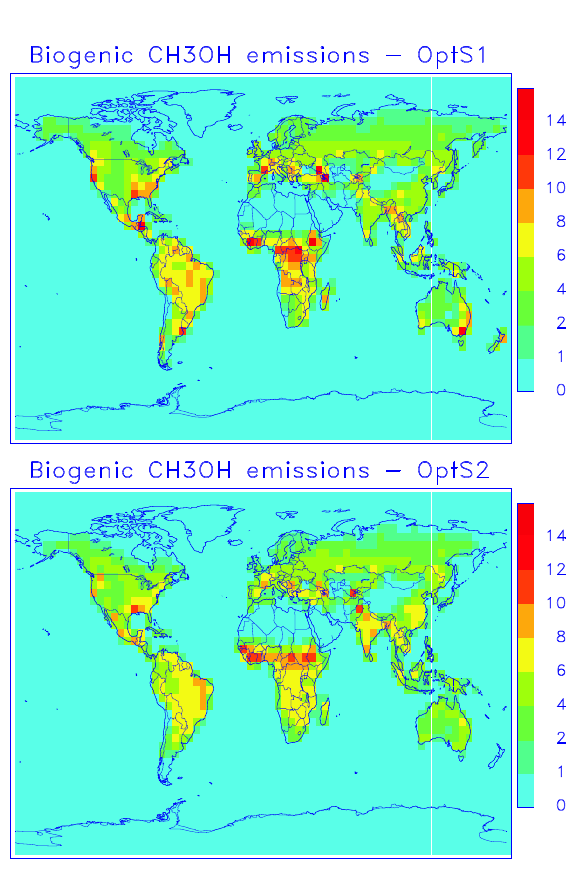
Fig. 15. Annually averaged biogenic methanol emissions derived by the inversion OptS1, which uses the Jacob et al. (2005) biogenic sources as a priori, and by the standard OptS2 inversion. Units are 10 10 molec.cm − 2 s − 1 .